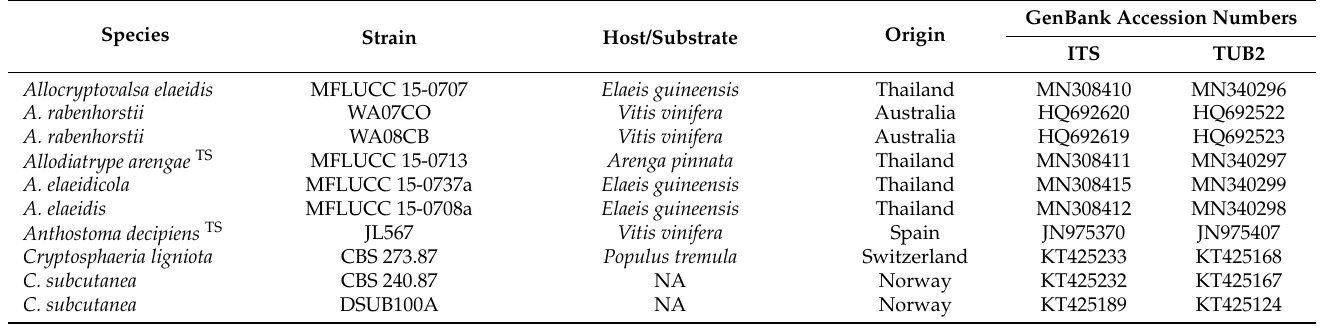
Table 1. List of species, specimens, and GenBank accession numbers of sequences used in this study.